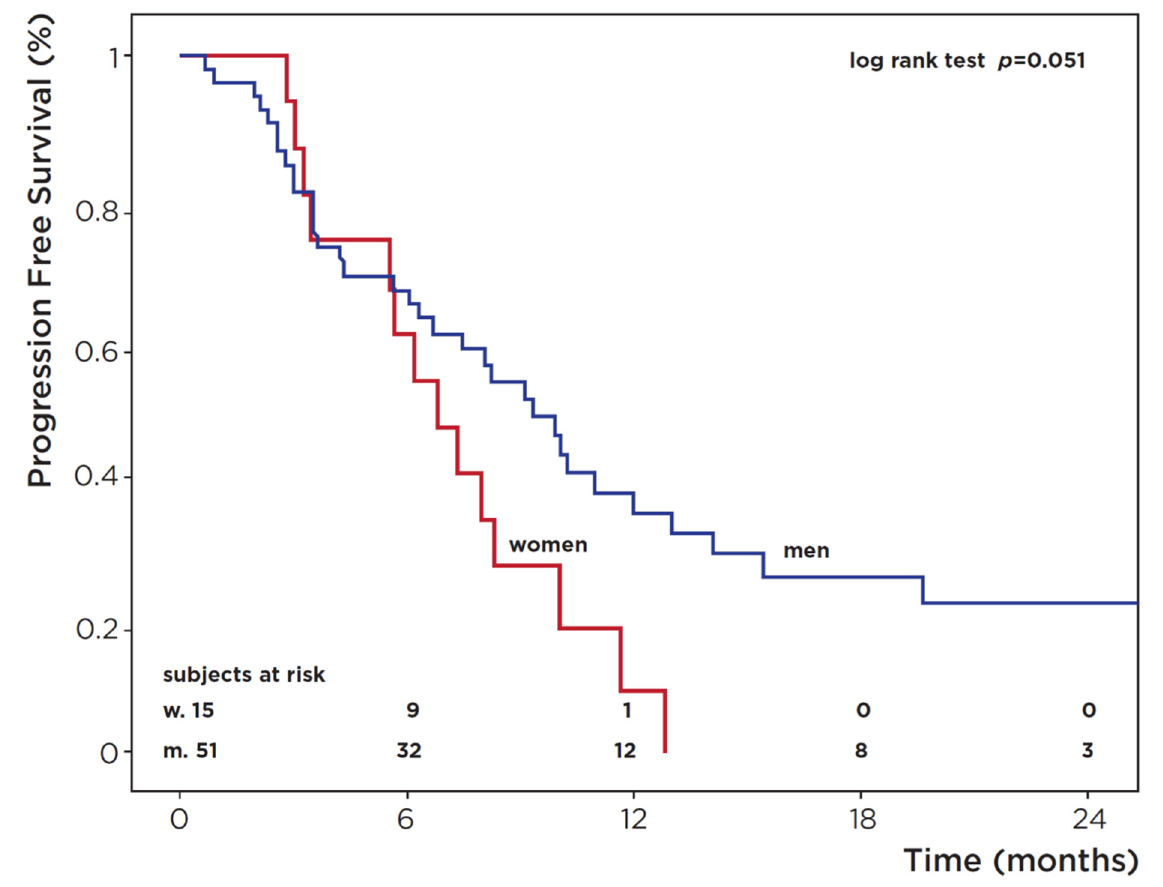
Figure 2. Progression-free survival (PFS) in patients with advanced urothelial cancer.